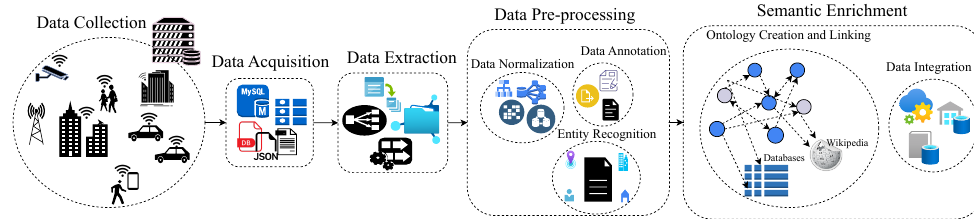
Figure 1. Semantic Data